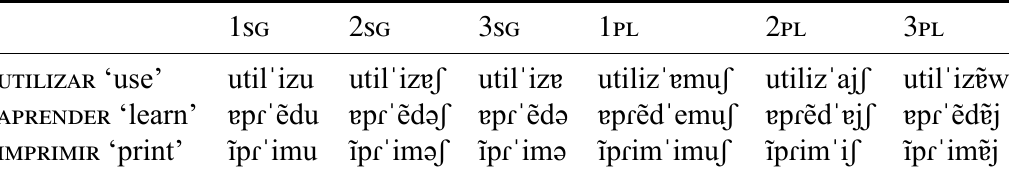
Table 1: The present indicative of three verbs, each representative of one of the three main inflectional